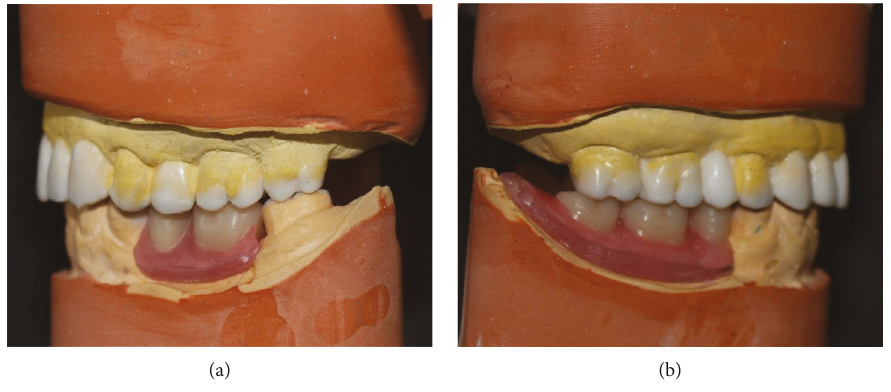
Figure 3: (a, b) Diagnostic wax up in lateral